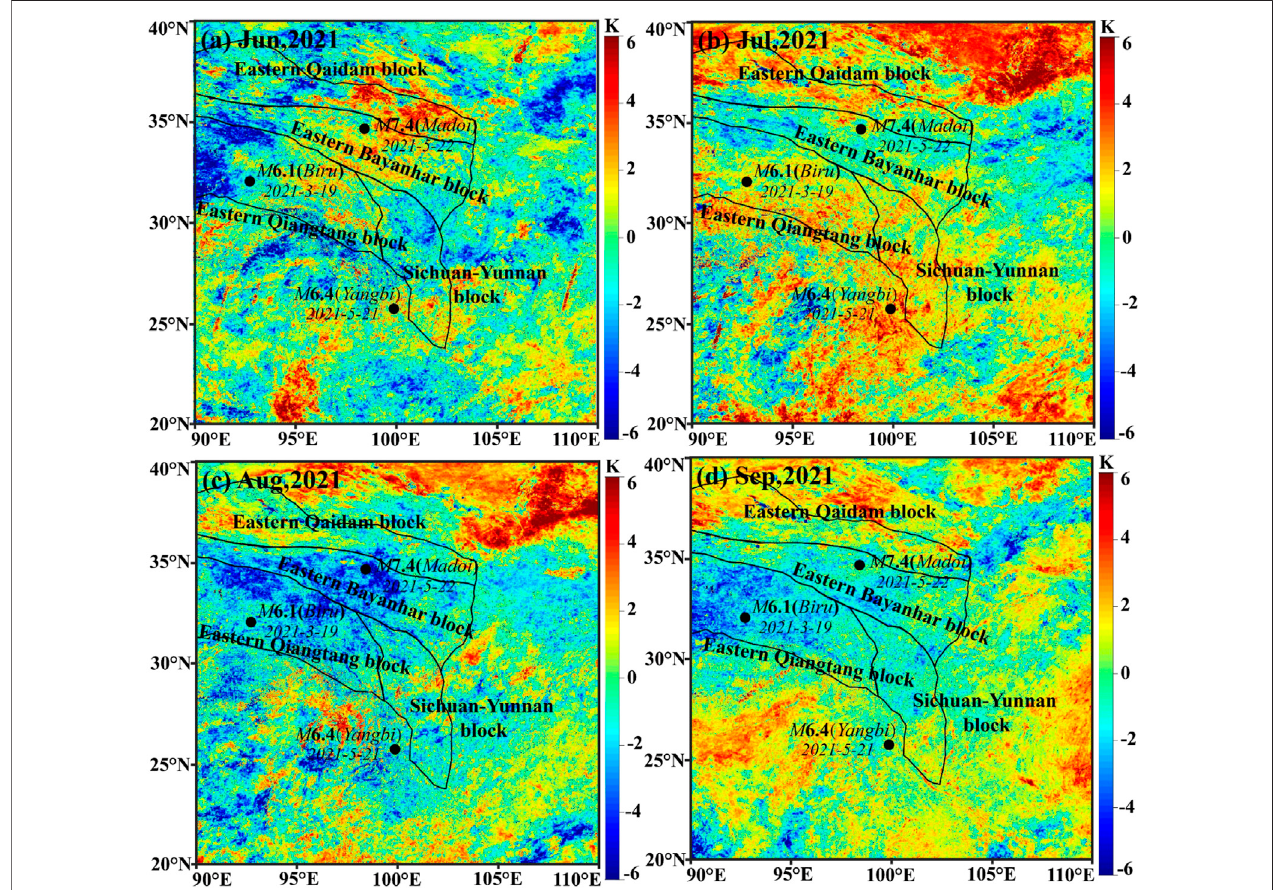
FIGURE 5 | BT anomaly in the eastern margin of the Qinghai-Tibetan Plateau (2021.06 (A) -2021.09 (D) ).